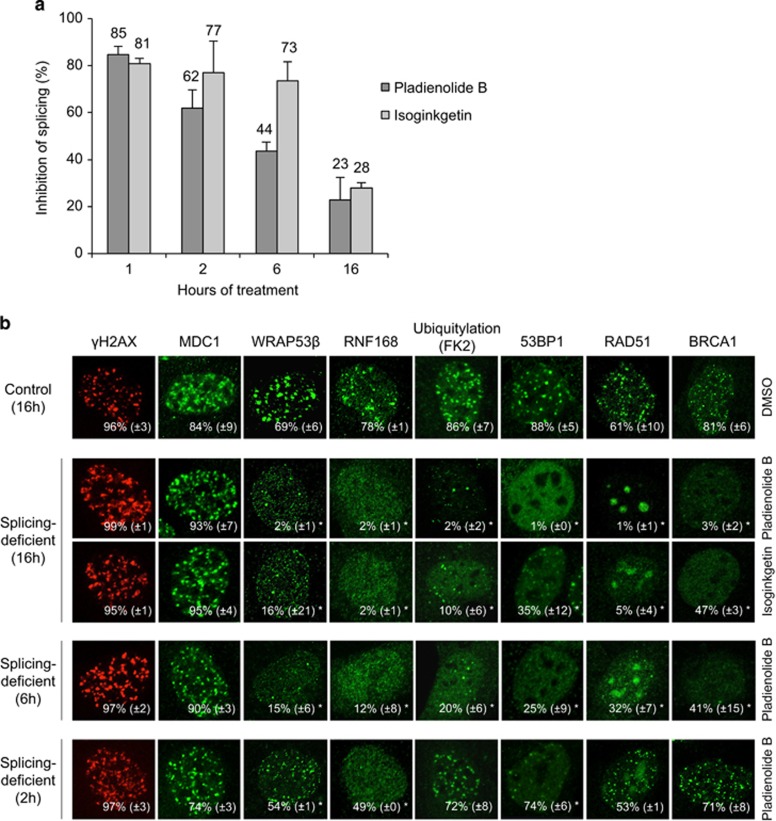
Recruitment of DNA repair factors to double-strand breaks is impaired in splicing-deficient cells. (a) HeLa Luc-I or Luc cells were exposed to DMSO (control), 100 nM pladienolide B or 50 μM isoginkgetin for 1–16 h. After normalization to the corresponding DMSO value, the ratio between Luc-I and Luc luciferase activity is presented as a percentage. Means±S.D. are shown, n=4. (b) U2OS cells were treated with pladienolide B or isoginkgetin for 2, 6 or 16 h, irradiated (6 Gy, 1 h recovery) 1 h prior to termination of the treatment, fixed and immunostained for γH2AX, MDC1, WRAP53β, RNF168, conjugated ubiquitin recognized by the FK2 antibody, 53BP1, RAD51 or BRCA1. Nuclei were stained with DAPI in all immunofluorescence experiments. The numbers in white represent the percentage of 100–200 cells counted whose nuclei contained >10 IR-induced foci. Means±S.D. are shown, n=3. *P-value<0.05, as determined by a non-paired two-tailed Student's t-test. The ‘foci-like' accumulations RAD51 after splicing inhibition in (b) are not IR-induced foci, but accumulation of RAD51 in the nucleolus for unknown reasons